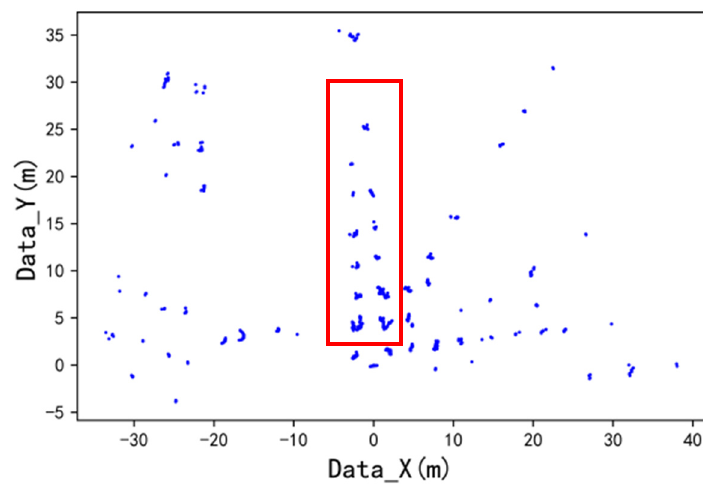
Figure 5. A frame of original data.